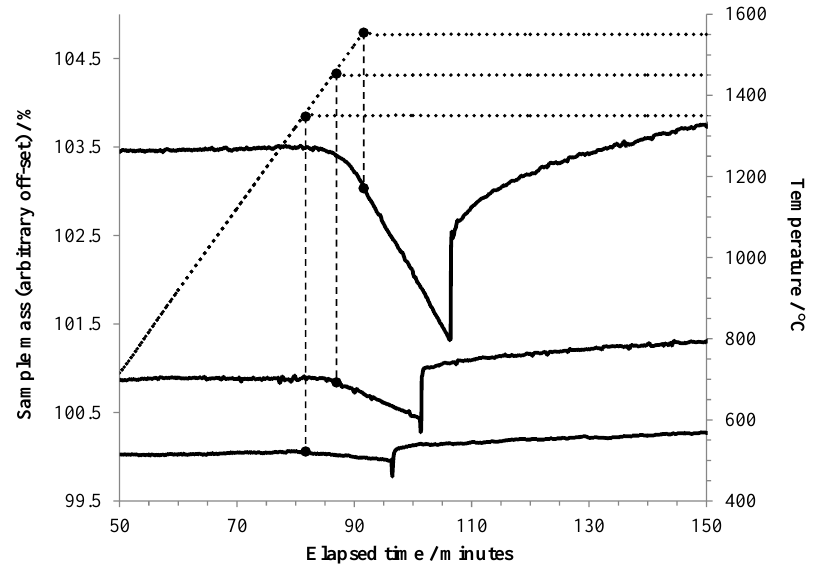
Figure 4. TGA results foraluminum heated to 1350 °C or higher under argon, held at that temperature for 15 min, then exposed to air. The vertical dashed lines tie the respective TGA curves to the point on the temperature curve (dotted line) where the isothermal hold began. In this plot, the beginning of each experiment is taken as t = 0. The point at which air flow began is recognized by the sudden mass increase in each curve.